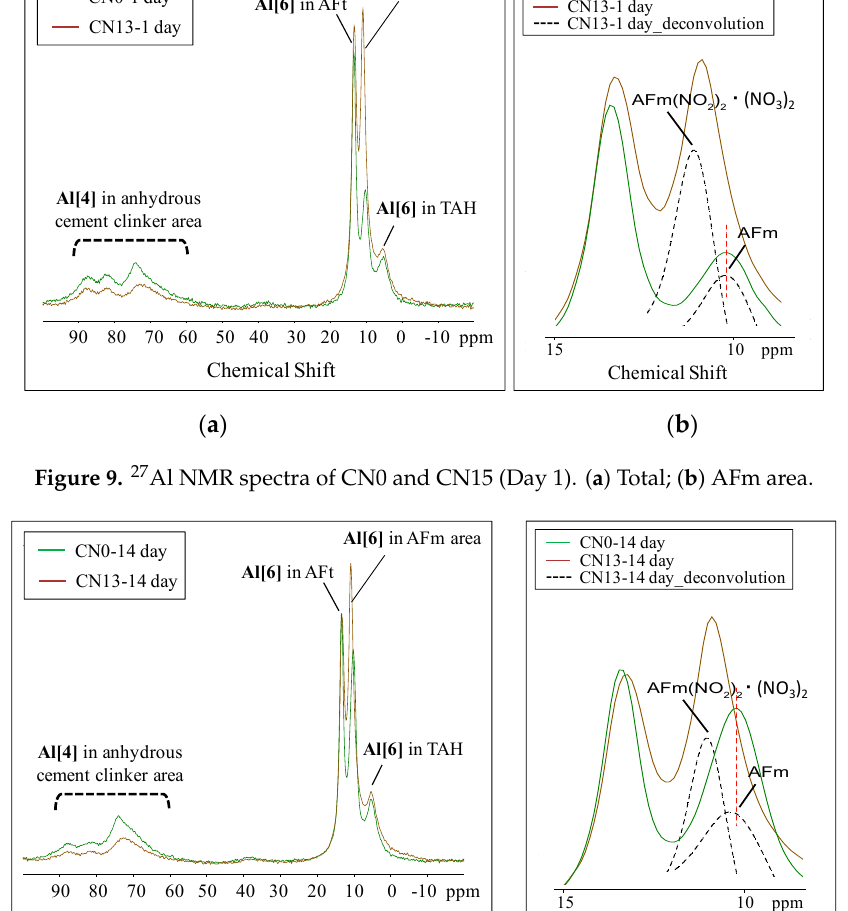
Figure 9. 27 Al NMR spectra of CN0 and CN15 (Day 1). ( a ) Total; ( b ) AFm area.